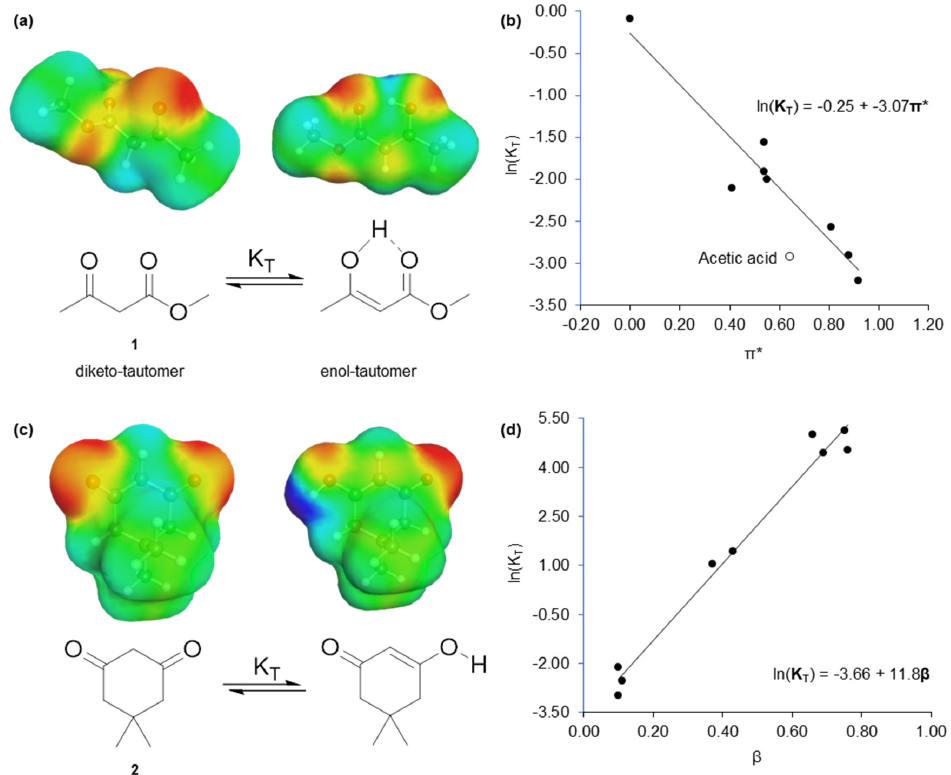
Figure 1. The solvent effect on the tautomerisation of acyclic and cyclic 1,3-dicarbonyl compounds. ( a ) The tautomerisation of 1 , with σ -surfaces superimposed over the lowest energy conformation of both tautomers; ( b ) The tautomerisation of 1 is inversely proportional to π * due to the smaller dipole moment of the enol-tautomer; ( c ) The tautomerisation of 2 ; ( d ) The free energy relationship between the tautomerisation of 2 and β showing stabilisation of the enol-tautomer is provided by hydrogen bond accepting solvents.